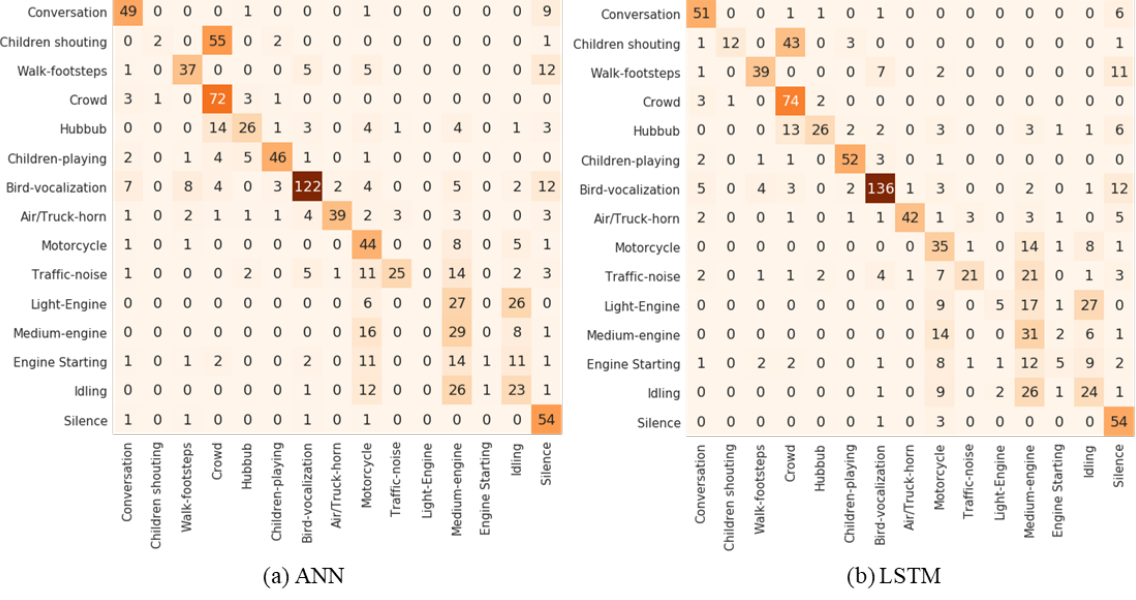
The softmax function applied in the output layer provides probabilities for each class considered in the model. The class with the highest probability is considered as a model prediction for the corresponding